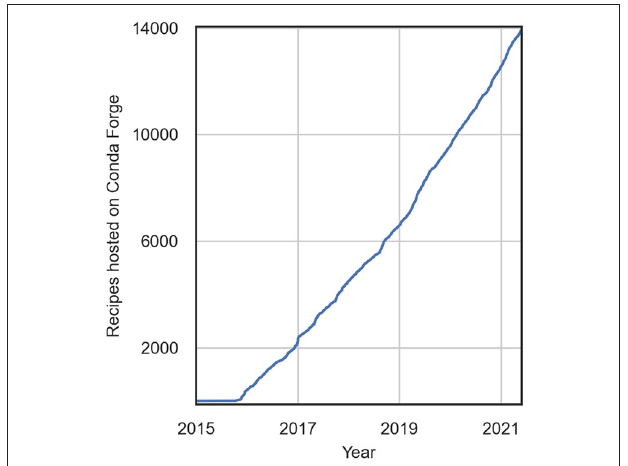
FIGURE 1 | Number of software installation recipes hosted on Conda Forge by